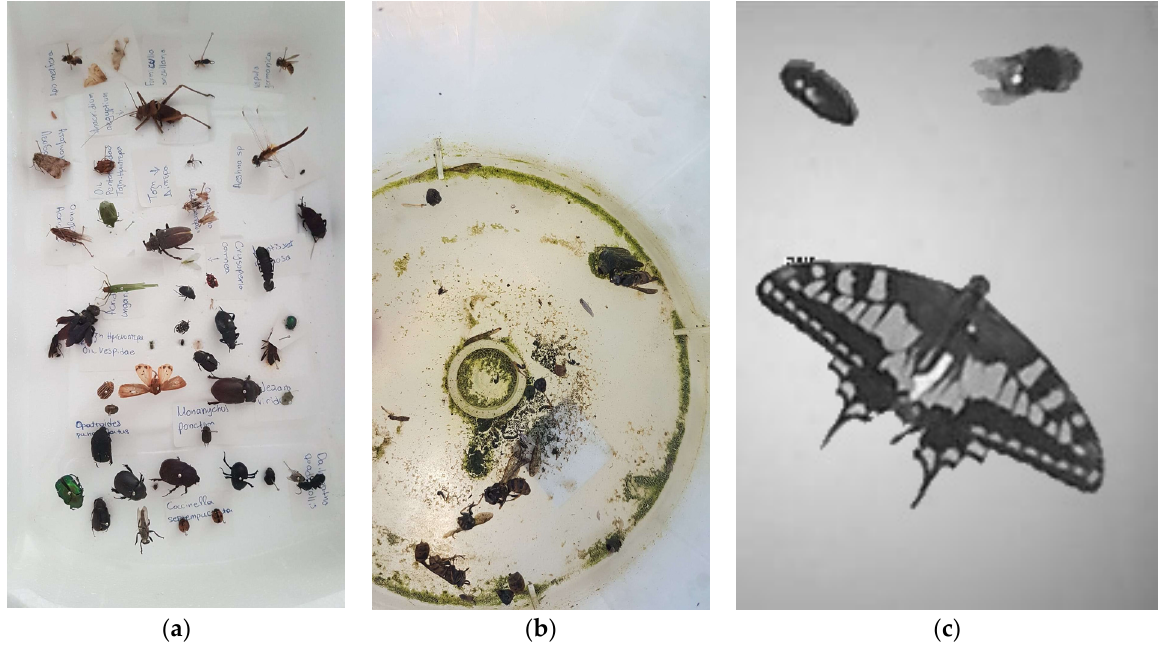
Figure 2. ( a ) A subsample of insects used to make the reference database. ( b ) A typical photo from a funnel trap in the field. ( c ) A photo from the internal space of the suggested device (ESP32-CAM).